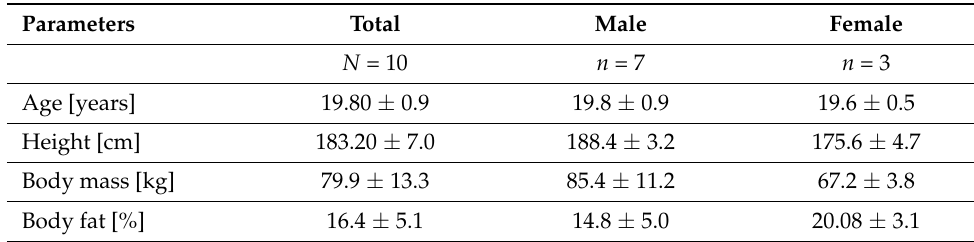
Table 1. Anthropometric